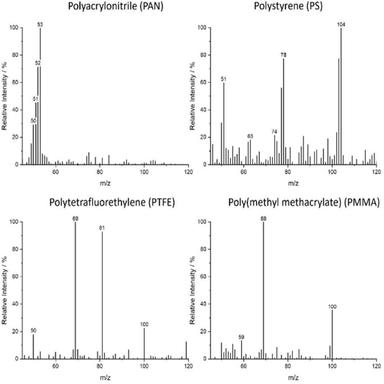
Laser Ablation- EI-MS spectra obtained from four different polymers samples.